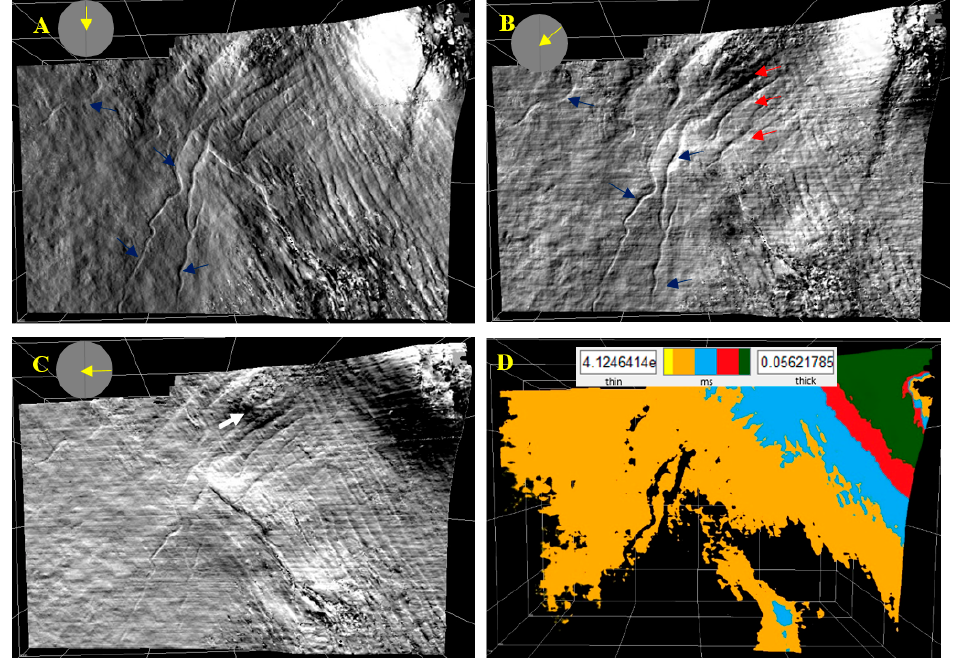
Figure 11. The apparent dip attribute for MFS1 surfaces at ( A ) 0°, ( B ) 45°, ( C ) 90 ° , and ( D ) the Isopach map. The blue arrows indicate the deep meandering channels, the red arrows indicate the existence of a minor sub-seismic fault which is only clearly visible in ( B ) while the white arrows highlight the existence of pockmark.